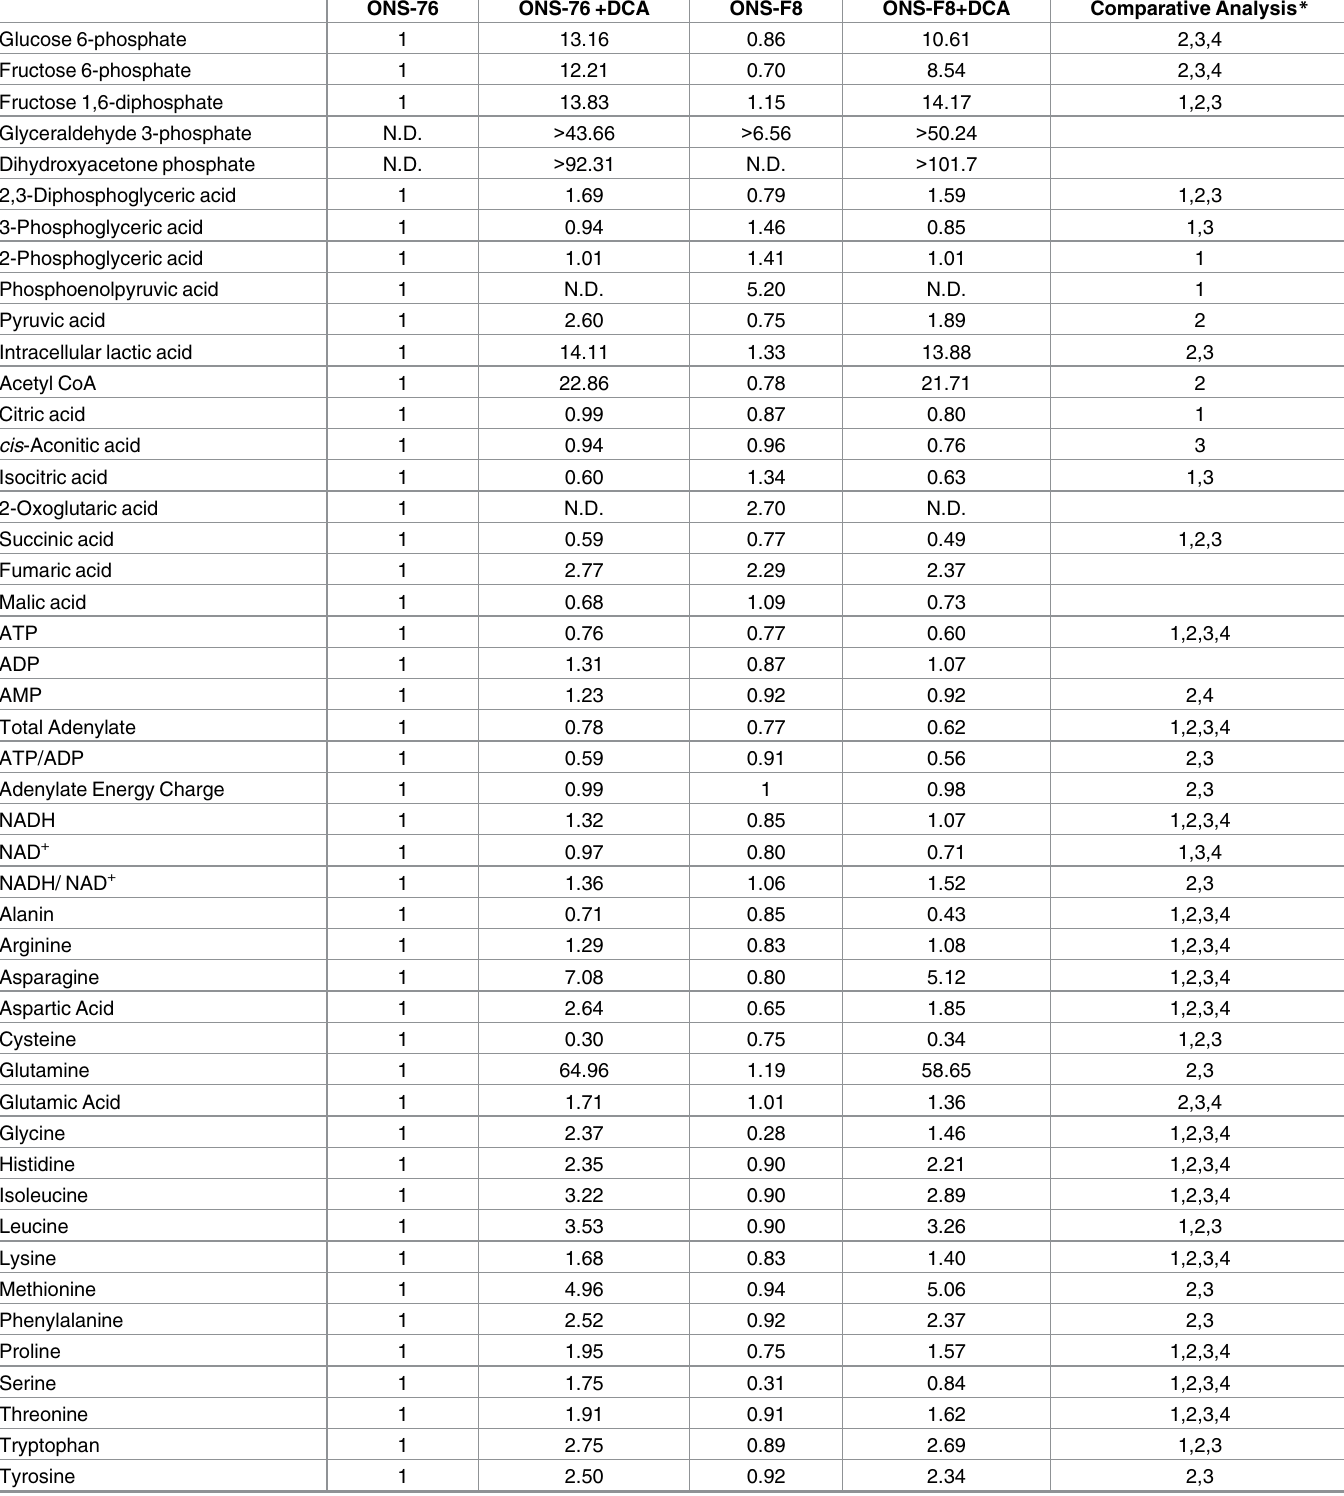
Table 1. Relative glycolysis and TCA cycle related metabolites in ONS-76 and -F8 cells with and without